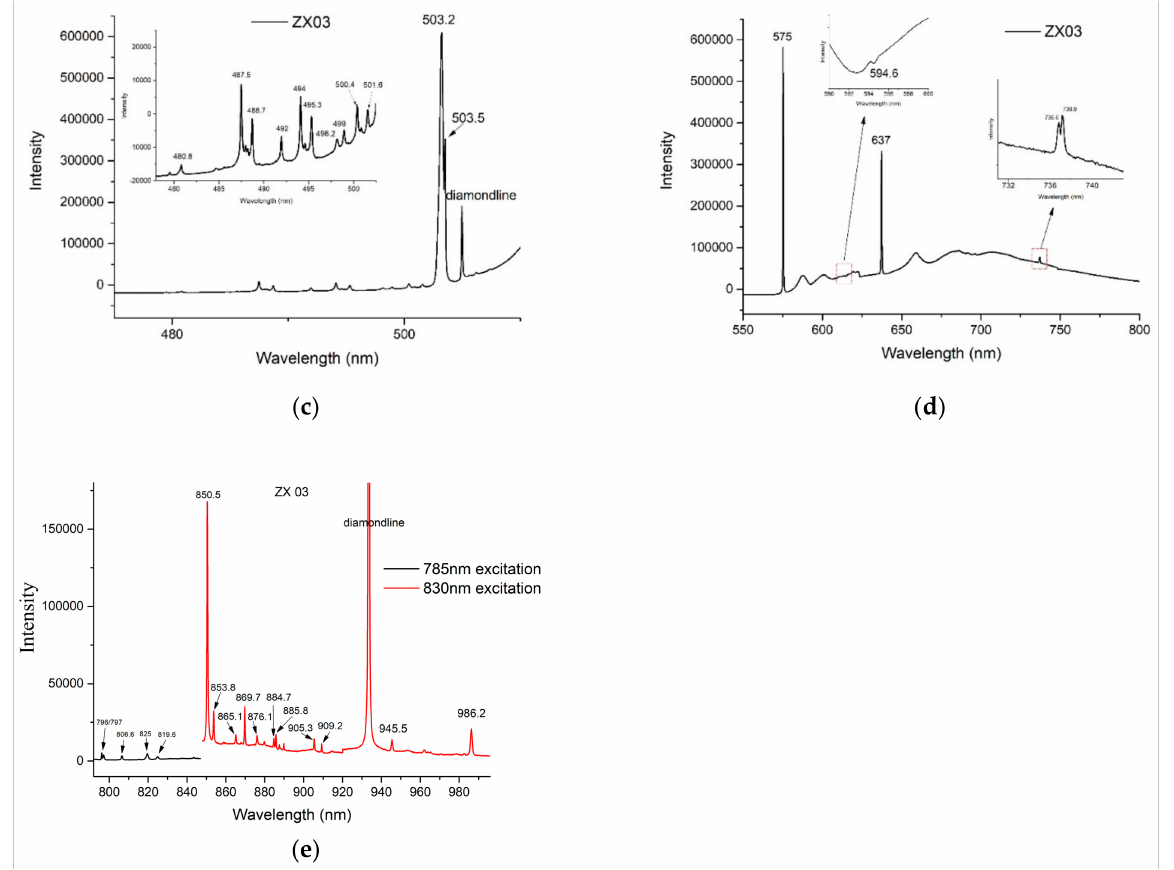
Figure 7. Numerous emission lines are present in the PL spectra of these synthetic diamonds. Distinct 388.9 nm peak could be detected in all the samples with the 325 nm laser excitation ( a ). Several emissions and relatively strong H3 and 3H peaks in the 480–510 nm regions were observed with the 473 nm laser excitation ( b , c ). Extremely strong NV emissions and negative 594.6 nm reported with the 532 nm laser excitation ( d ), and many emissions including 986.2 and 945.5 nm when excited by the 785 and 830 nm lasers ( e